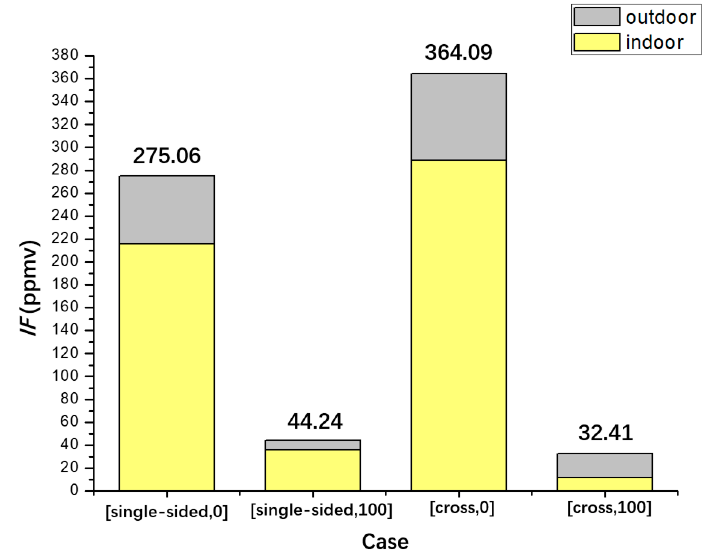
Figure 8. Intake fraction IF in four